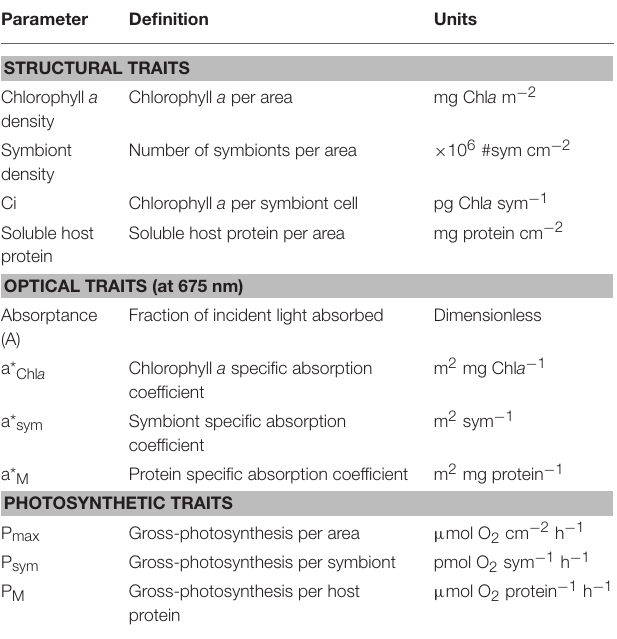
TABLE 1 | Table of terms, definitions, and units for the structural, optical, and photosynthetic traits used in this